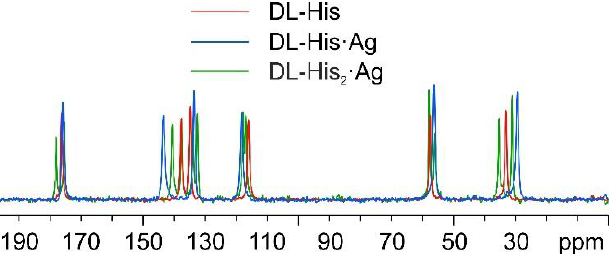
Figure 13. Overlay of the 13 C CPMAS spectra of DL-His 2 ·Ag (in green), DL-His·Ag (in blue), and pure DL-His (in red).